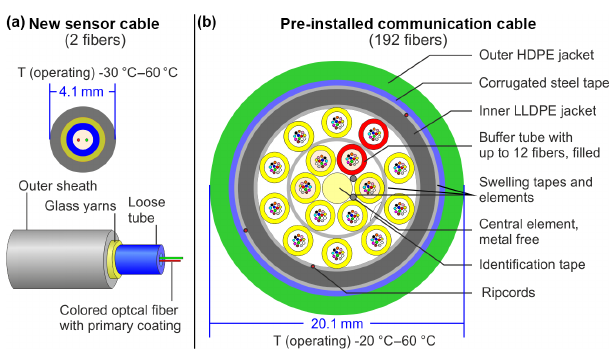
Figure 1. Schematic layout of the used sensor cables: (a) new sen- sor cable and (b) pre-installed communication cable.